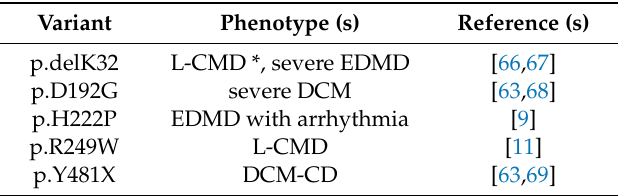
Table 1. Phenotypes associated with the studied LMNA variants. DCM—dilated cardiomyopathy; DCM-CD—dilated cardiomyopathy with conduction defects; EDMD—Emery–Dreifuss muscular dystrophy; and L-CMD— LMNA related congenital muscular dystrophy.